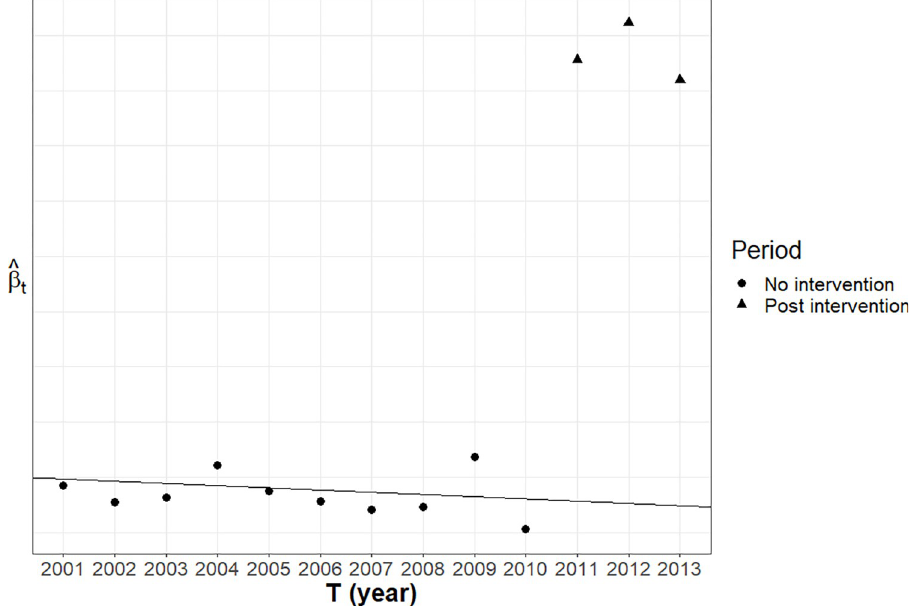
Fig 1. Example of an interrupted time series using police.uk data. ^ b ^ regression slope) between house prices and either number of snap-point or geomasking error. A change in ^ b ^ launch of police.uk in 2011 indicates causality. We can also check for a constant trend in ^ b ^ (e.g. ^ b ^ doesn’t wildly fluctuate for no T